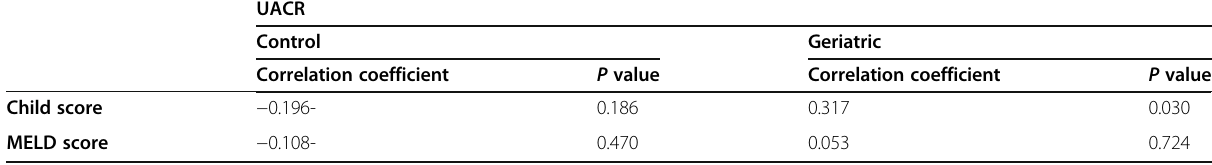
Table 2 Correlation between urine albumin creatinine ration, Child and MELD scores